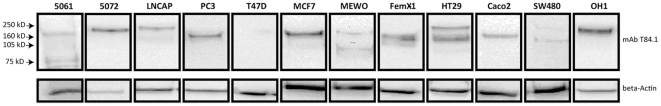
Western blot analysis of the CEACAM protein expression pattern.CEACAM family members as detected by pan CEACAM specific antibody T84.1 were present in all cancer cell lines except T47D. Beta-actin was used as a loading control.